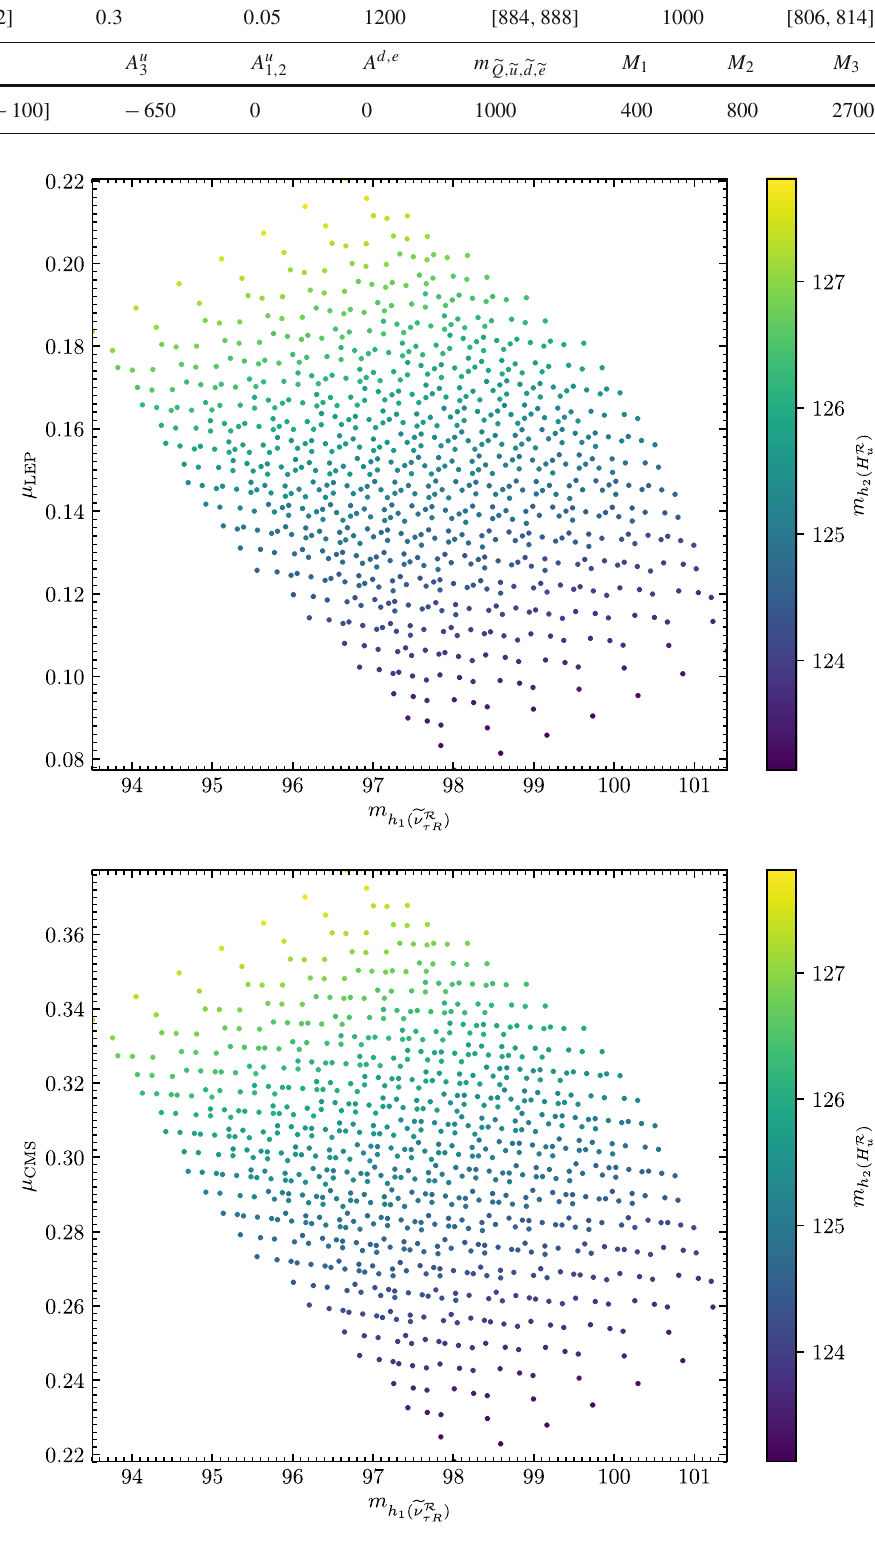
Table 5 Parameters of the scan to fit the LEP and the CMS excesses. Dimensionful parameters are given in GeV. If the family index is omitted the parameter has a universal value independent of the index tan β